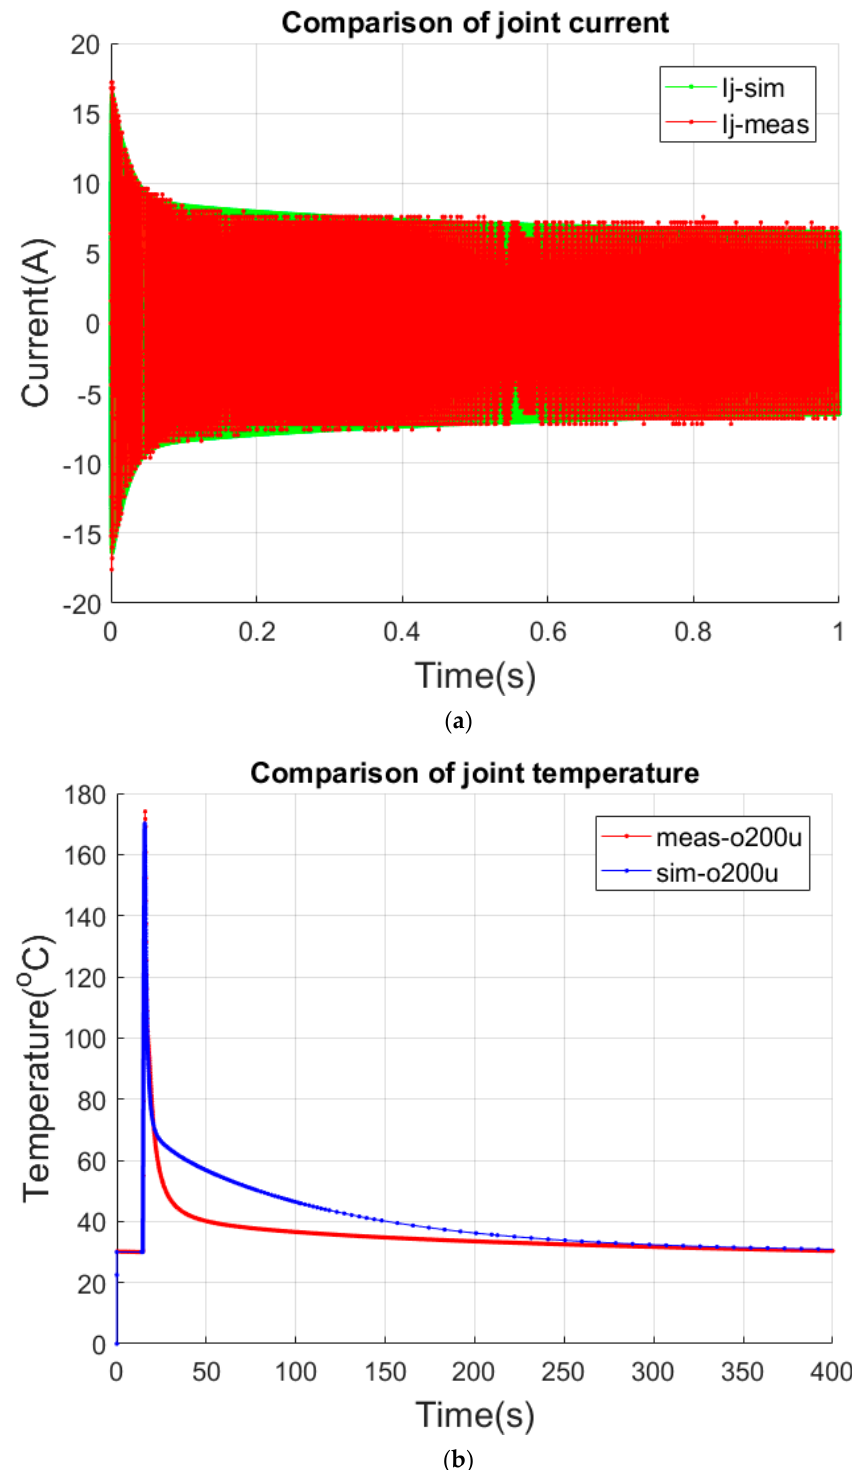
Figure 13. ( a ) Measured current through the IOFEF joint; ( b ) Measured thermal response of 300 s at Lo200. The comparison between the simulated and measured temperature at the first outer 200 μ m thick layer is shown in Figure 13b. The measured temperature was 174 °C, and the simulated temperature was 171 °C. Despite all the care in sample preparation and measurement, a difference of 3 °C could be seen between the simulated and measured